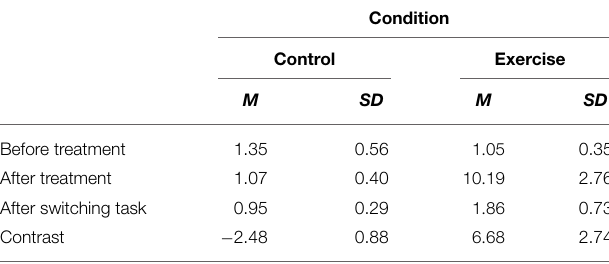
TABLE 2 | Blood lactate concentration ( N = 227